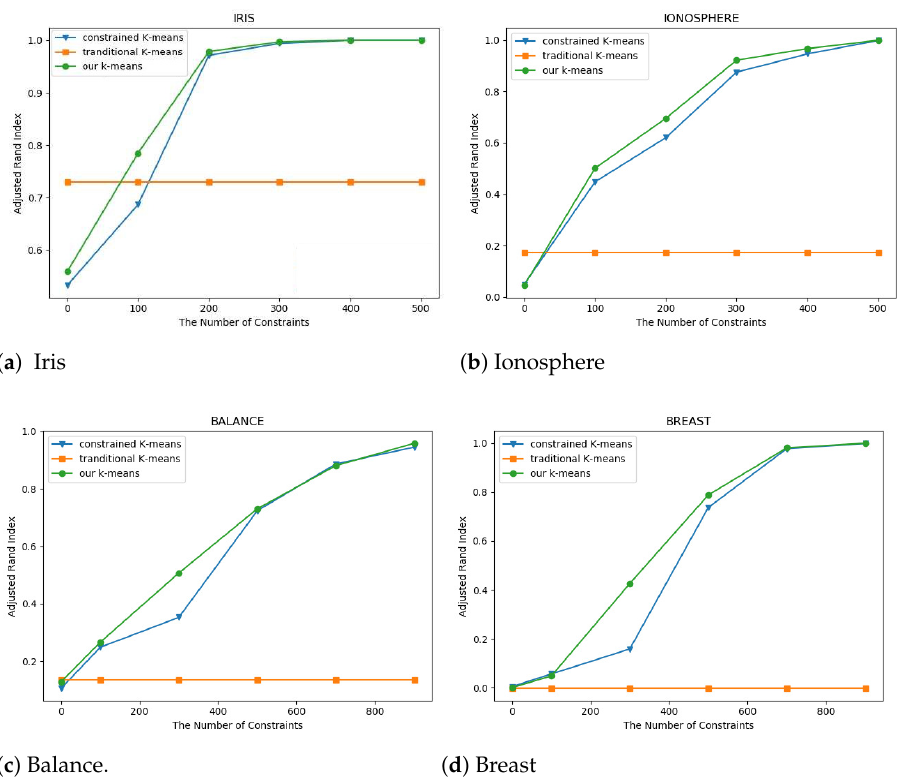
Figure 4. Comparison of the Adjusted Rand